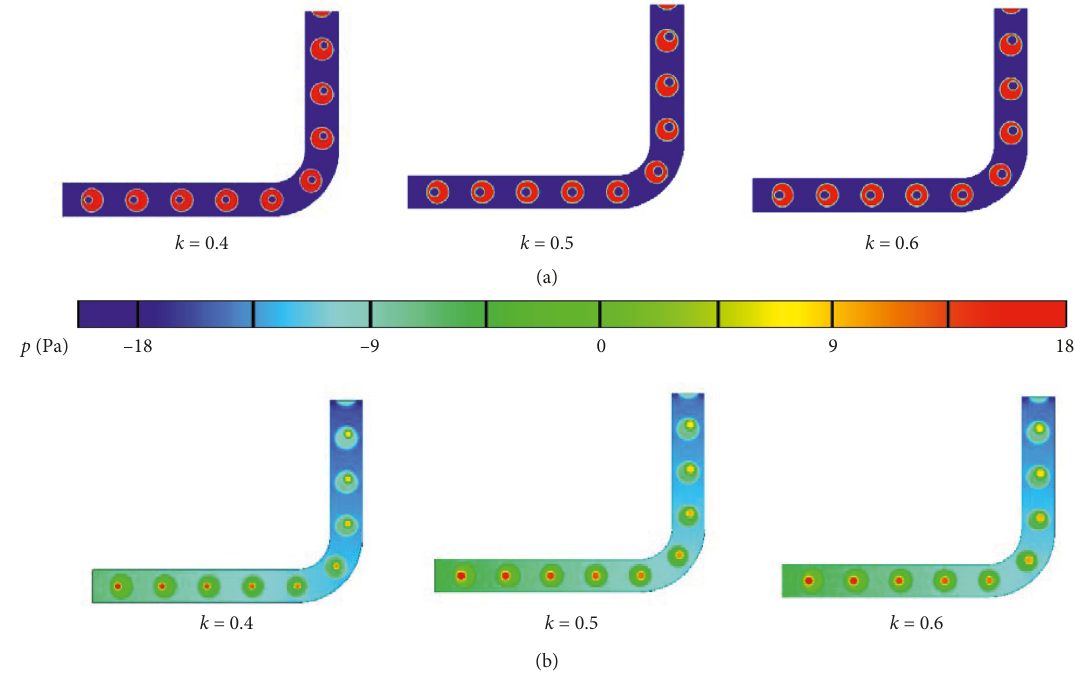
Figure 10: Effect of radius ratio on the compound droplet deformation: (a) interface shape; (b) pressure distribution.